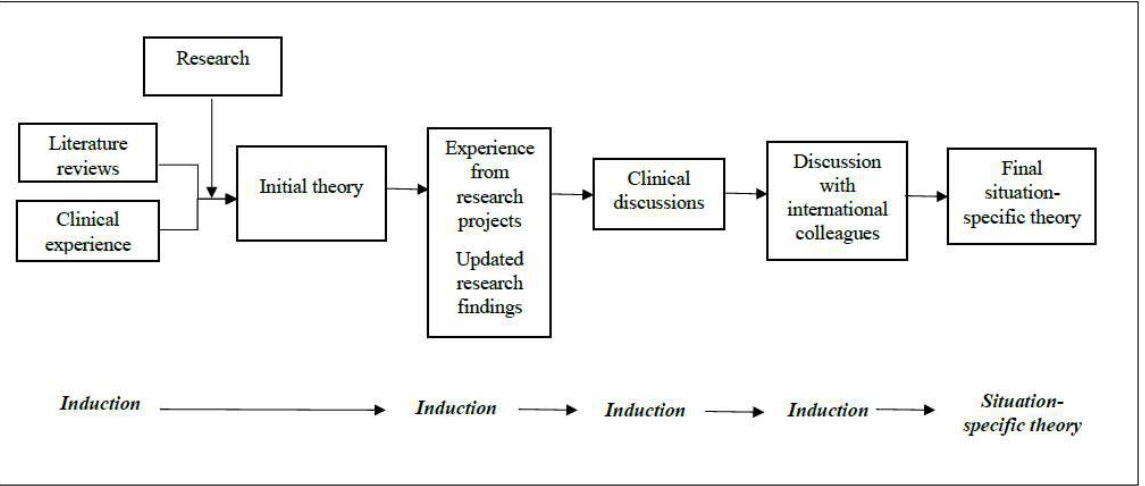
Figure 2. Theorizing Process of the Situation-Specific Theory of End-of-Life Communication in Nursing Home. Nursing